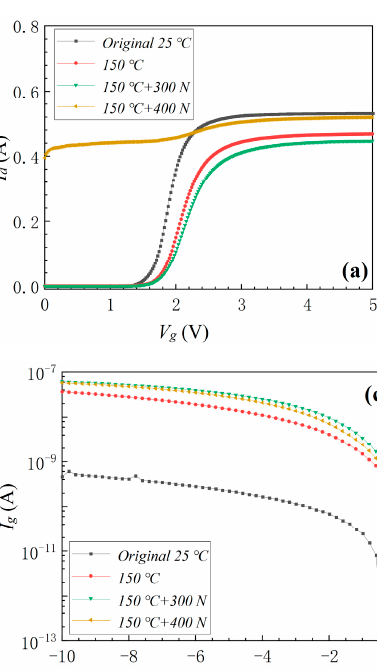
Figure 8. The device’s transfer characteristic ( a ), R on ( b ), I g ( c ), and I dss ( d ) before and after electro-thermal coupling stress.